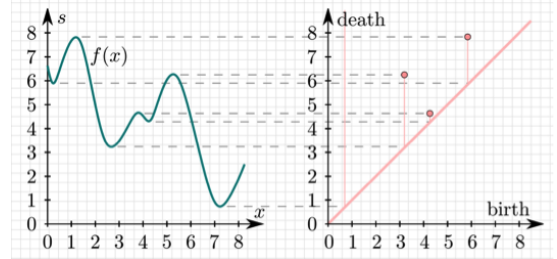
Figure A.1: Filtration of continuous function sublevels and PD